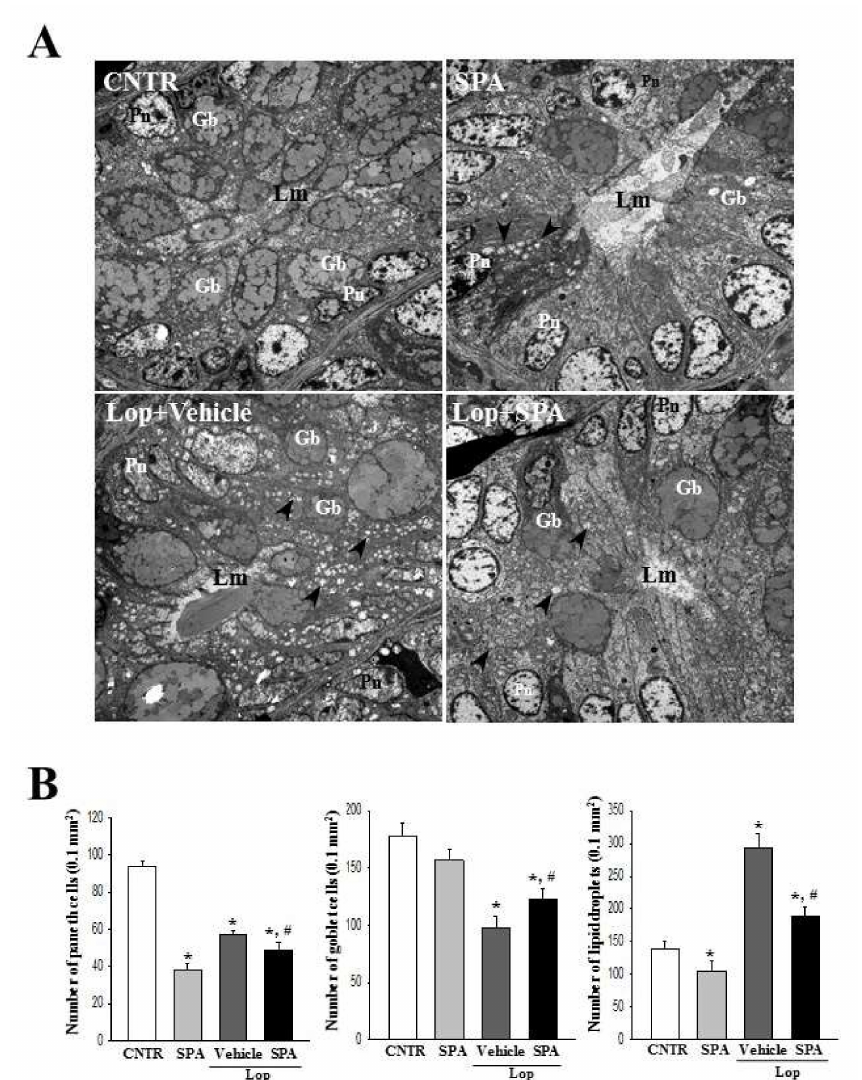
Figure 4. An ultrastructure image of the colon after SPA administration: ( A ) The ultrastructure of the crypt in the CNTR, SPA-, Lop + Vehicle- and Lop + SPA-treated groups were viewed by TEM at 4000 × magnification. ( B ) The number of paneth cells, lipid droplets, and goblet cells were measured using Leica Application Suite (Leica Microsystems, Switzerland). The arrow indicates a lipid droplet distributed around the lumen of the crypt. Two to three rats per group were used in the TEM analysis, and each parameter was measured in duplicate in two different slides. The data are reported as the mean ± SD. * indicates p < 0.05 compared to the CNTR group. # indicates p < 0.05 compared to the Lop + Vehicle-treated group. Lm, lumen of crypt; Gb, goblet cells; Pn, paneth